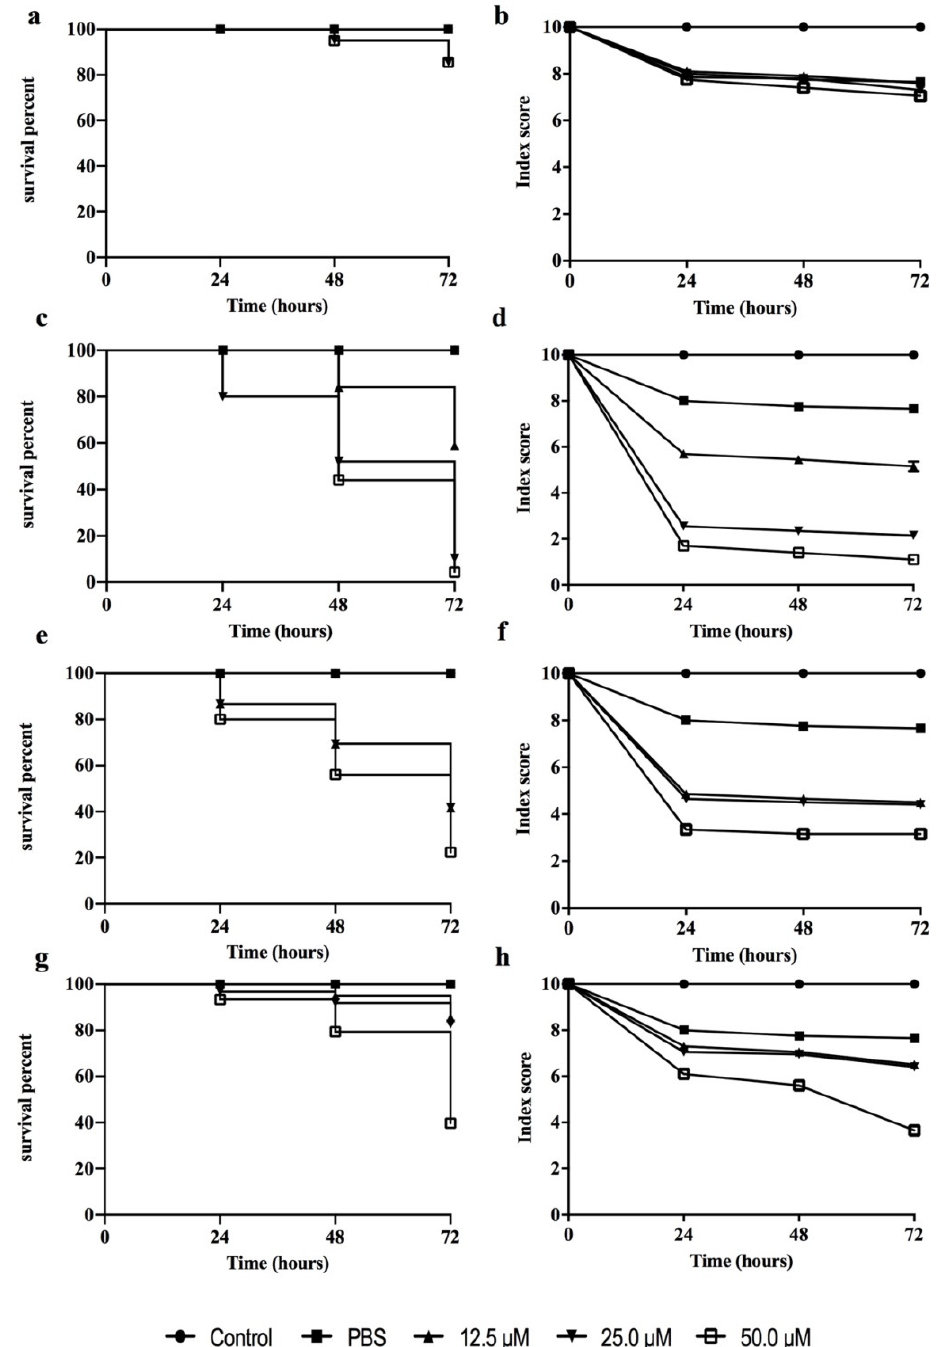
Figure 4. Peptide toxicity on G. mellonella larvae (on the left) and index score of G. mellonella (on the right) treated with the peptides 3 ( a , b ), 7 ( c , d ), 15 ( e , f ) and 16 ( g , h ) at the concentrations of 12.5 μ M, 25.0 μ M and 50 μ M.